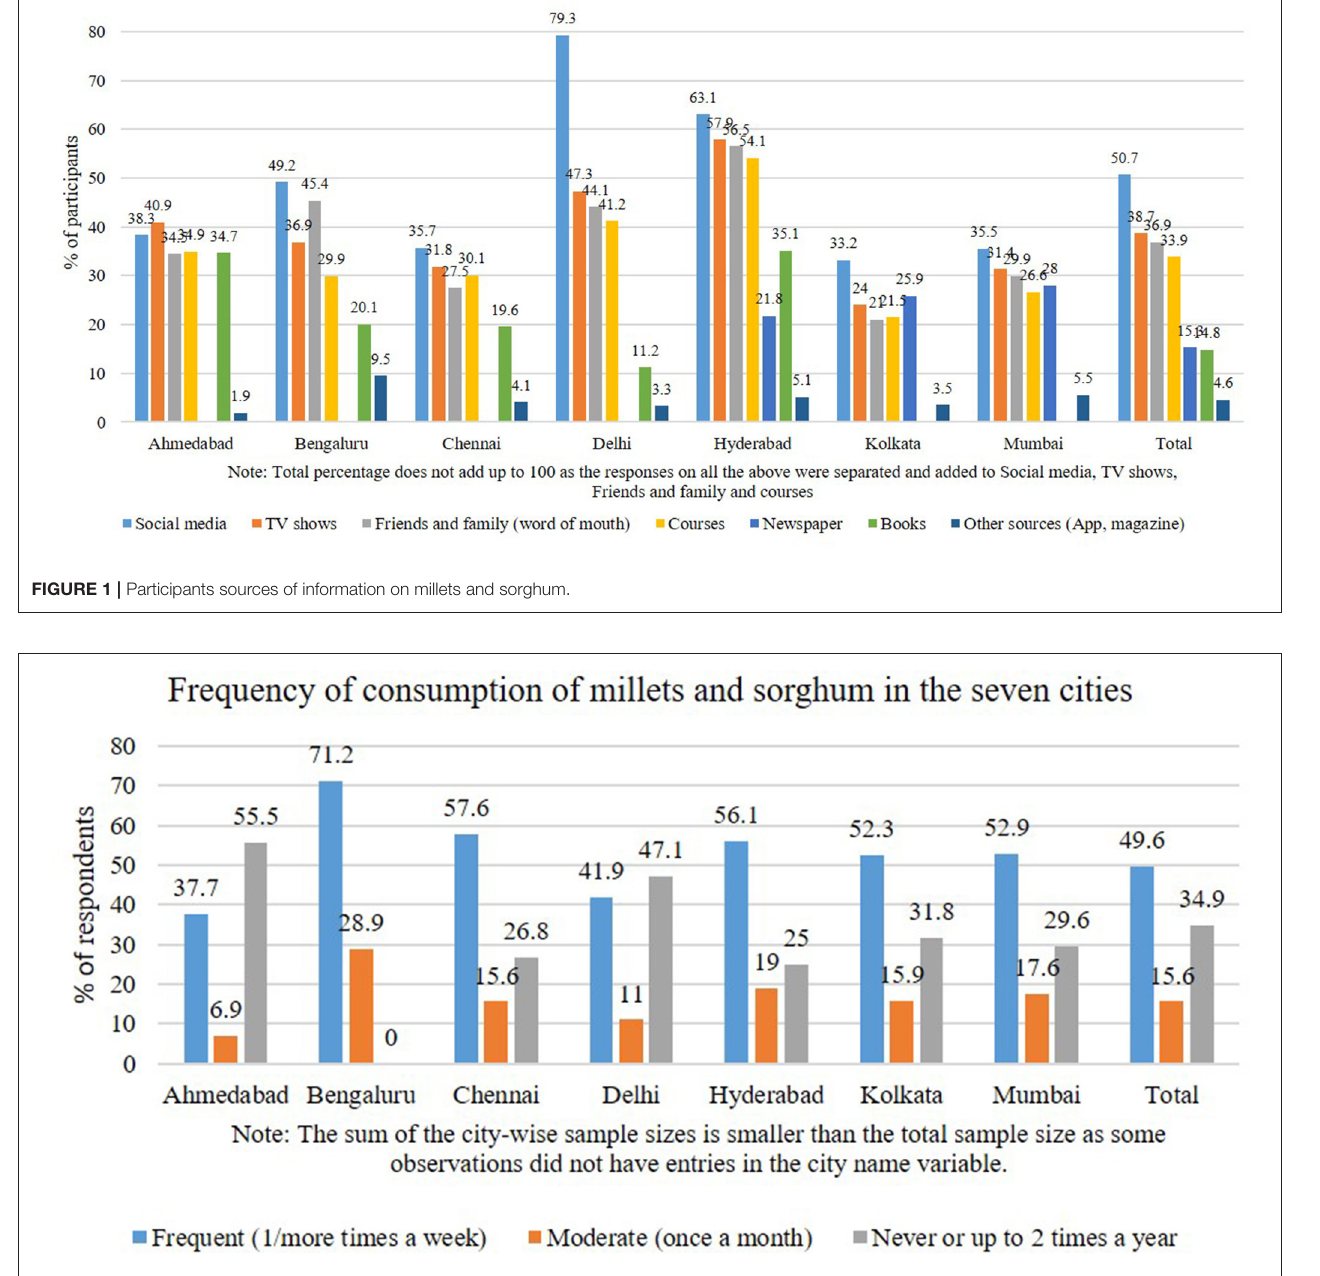
FIGURE 2 | Frequency of consumption of millets and sorghum by participants from seven